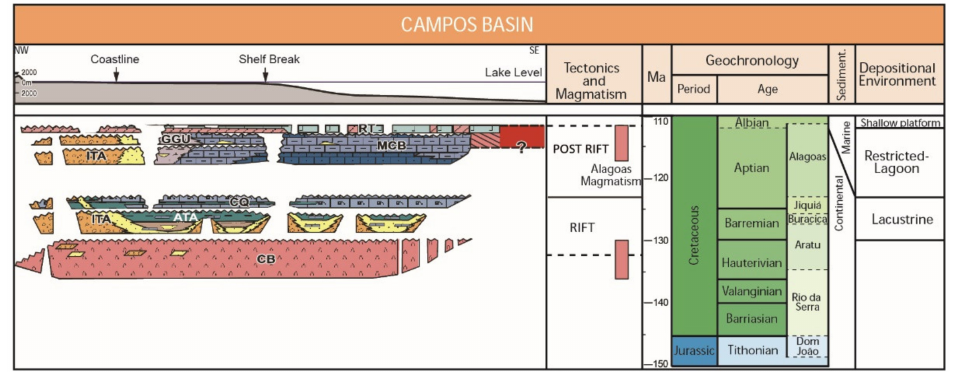
Figure 2. Stratigraphic chart of the rift section in the Campos Basin. The end of the rift section varies according to different authors. Modified from Alvarenga et al. [18]. (CB = Cabi ú nas Fm., ITA = Itapaboana Fm., ATA = Atafona Fm, CQ = Coqueiros Fm., GGU = Garga ú Fm., MCB = Macabu Fm., RT = Retiro